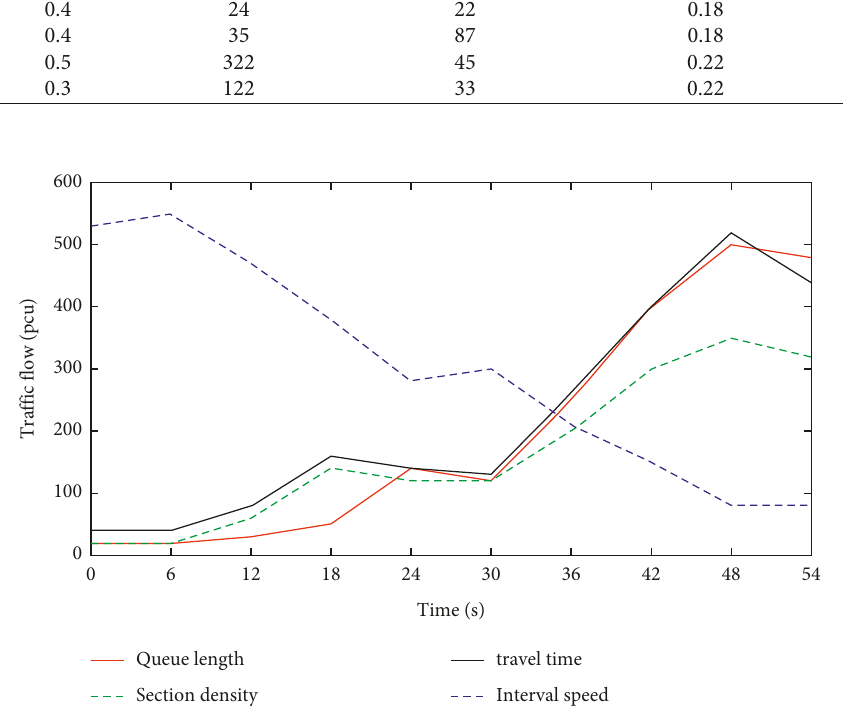
Figure 2: Change trend process of road